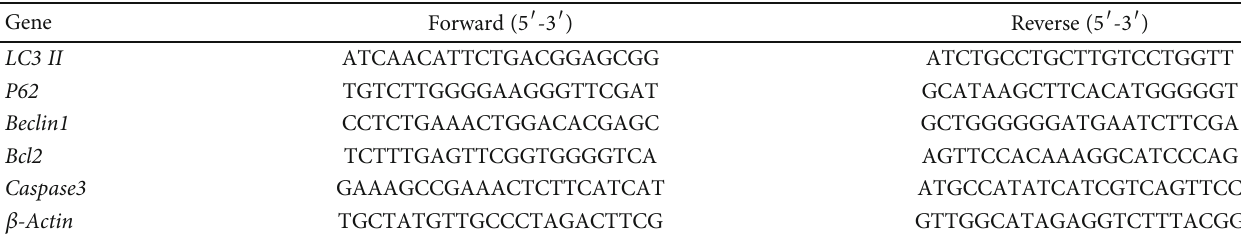
Table 1: Primers for